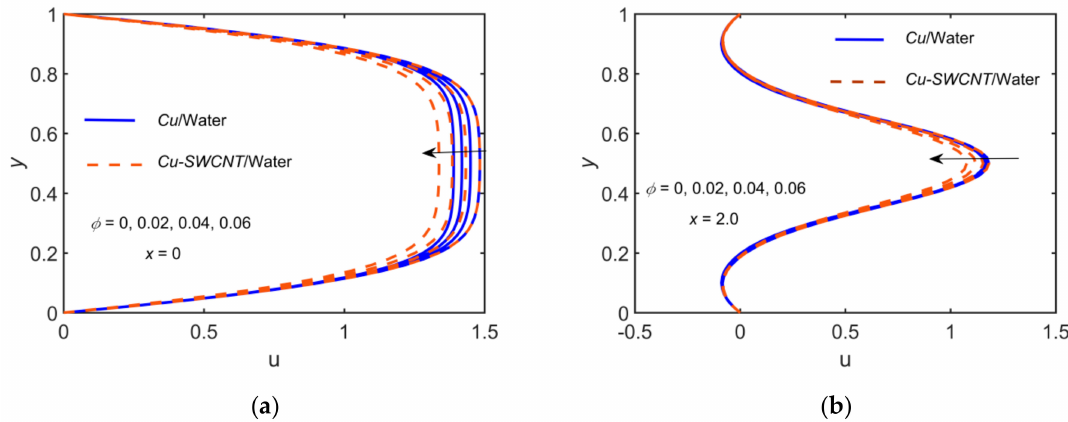
Figure 14. Comparison of Cu /water and Cu – SWCNT /water for the velocity profiles for φ = 0, 0.02, 0.04, and 0.06 with M = 5, St = 0.02 Pr = 1, Rd = 0.2, Re = 700, and t = 0.25 at ( a ) x = 0 ( b ) x = 2.